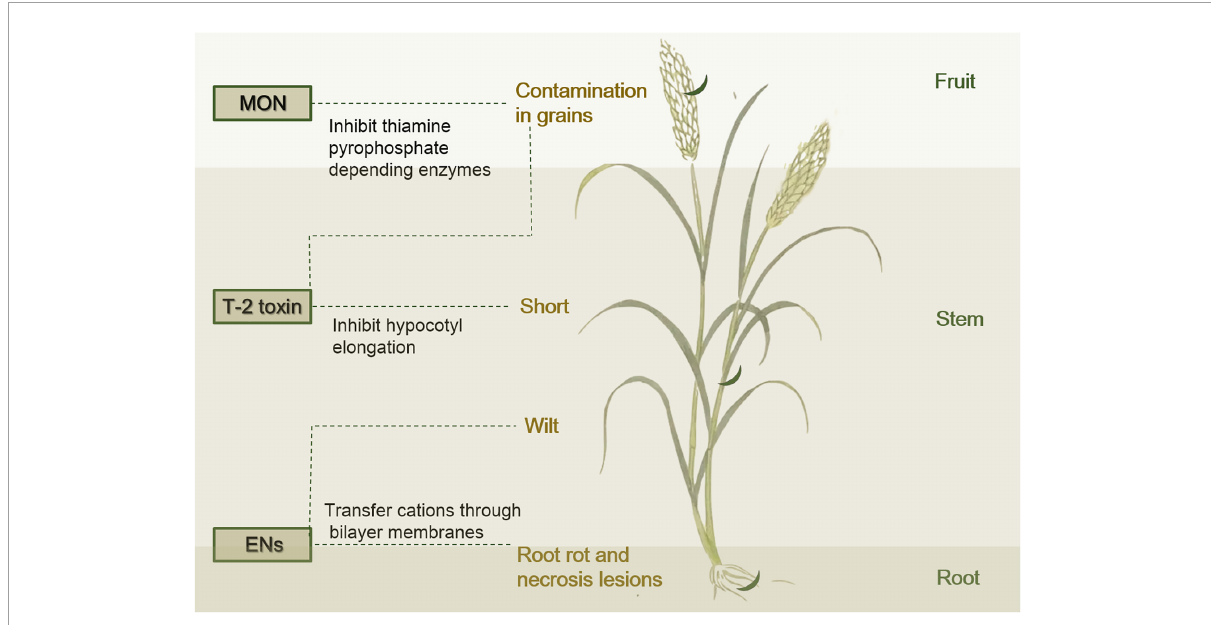
FIGURE4 Diagram that F. tricinctum (crescent moon in dark green) infects a plant, releases mycotoxins and causes disease symptoms in